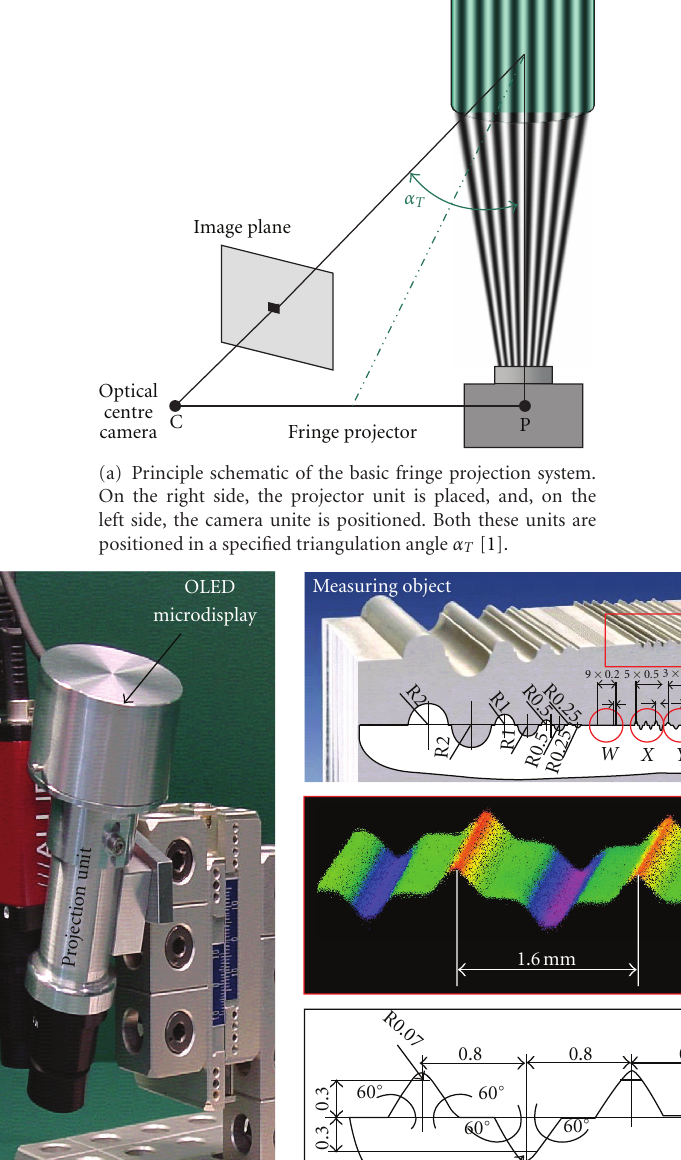
simultaneous or sequential emission (OLED projection) and detection (photodiode) can be realized [20]. In the sequential mode of operation, the OLED projection and photodiode detection are wavelength independent ( λ OLED / = λ photodiode